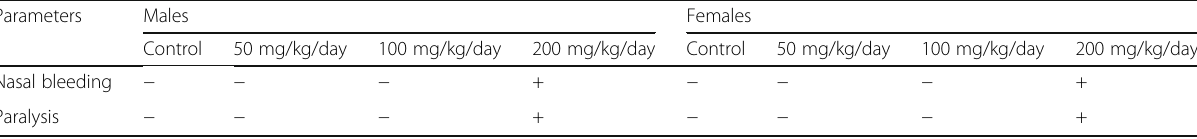
Table 2 Observations of physical signs during sub-acute toxicity study Parameters